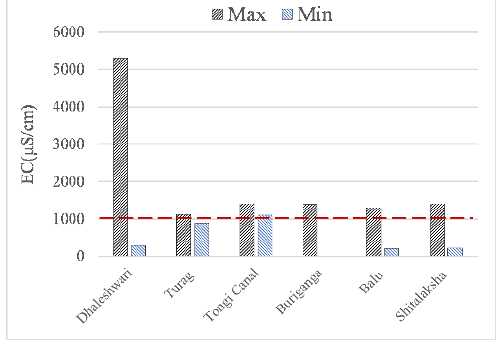
Figure 9. Max m vs. Min m Concentration of EC for the peripheral rivers of Dhaka for with WHO standard in dotted line (1000 μS/cm).